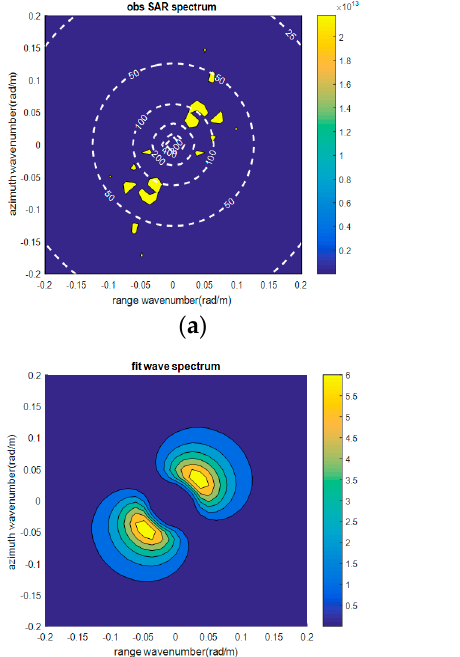
Figure 10. Data observed by SAR-3 as follows: ( a ) ocean surface backscattering coefficient and ( b ) ocean SAR image.